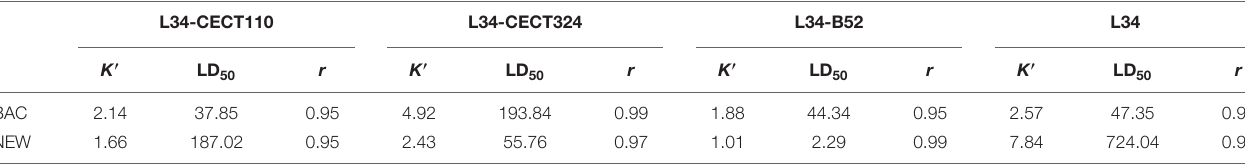
TABLE 3 | L34 maximum logarithmic reduction ( K (cid:48) ) and lethal dose 50 (LD 50 ) expressed in log CFU cm − 2 and µ g ml − 1 , respectively, in 48 h biofilms of L34 alone and co-cultured with CECT110, CECT324, and B52 after the application of a solution of BAC or NEW. L34-CECT110 L34-CECT324 L34-B52